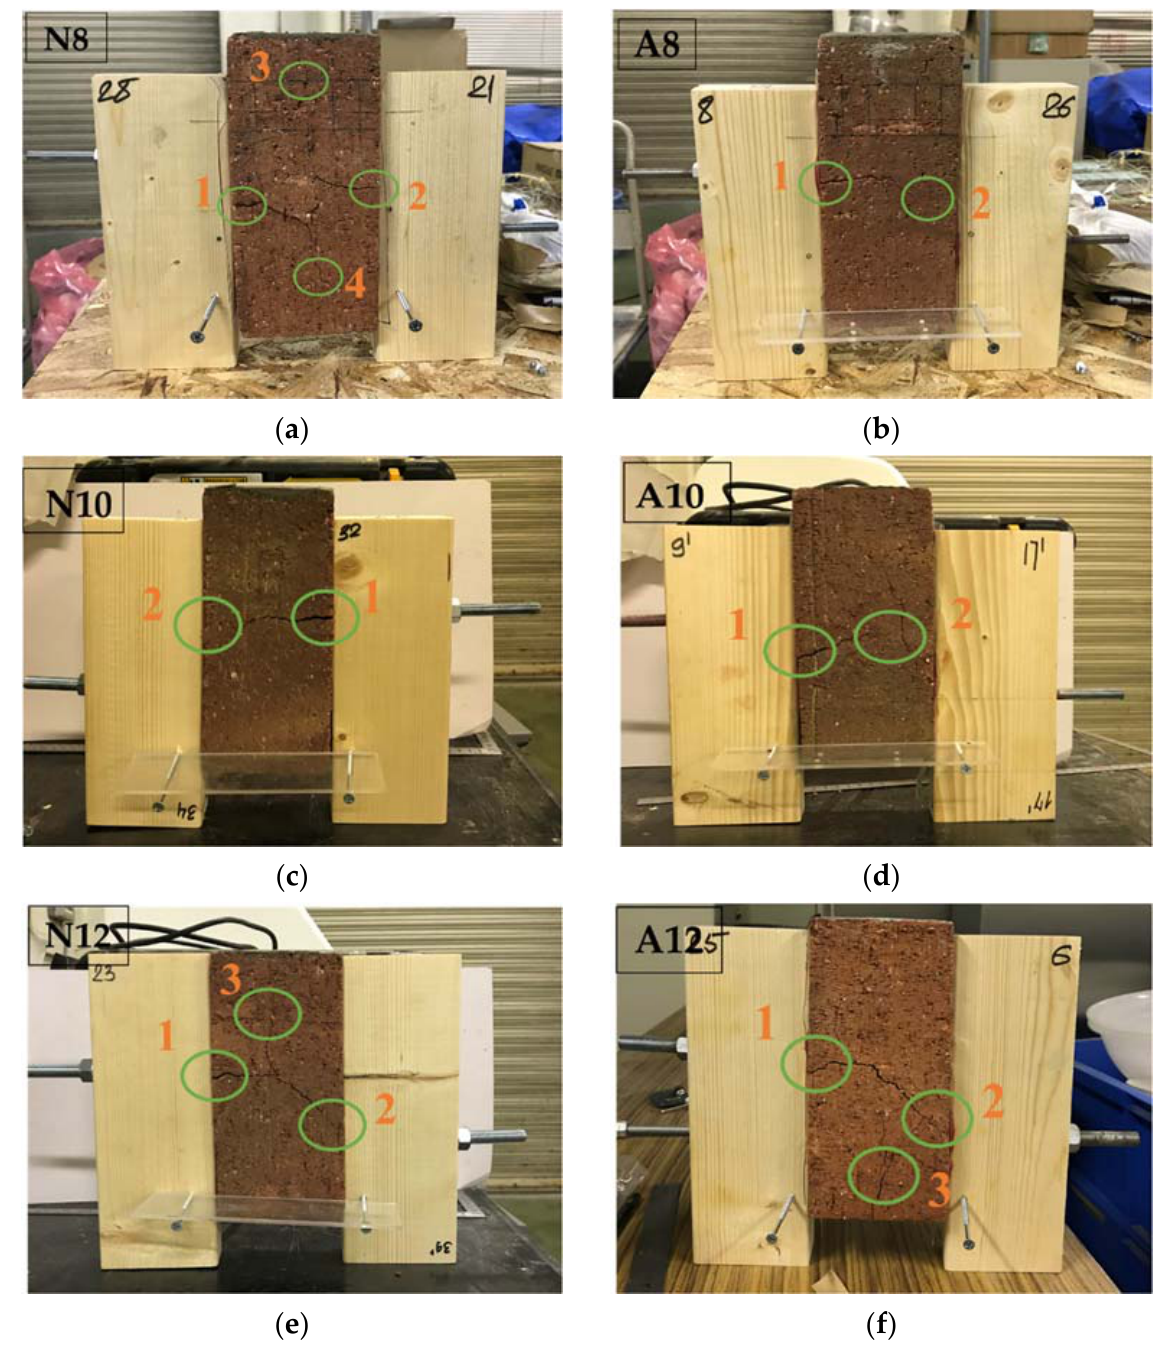
Figure 13. Crack on the brick (main member). ( a ) N8-1 specimen; ( b ) A8-1 specimen; ( c ) N10-2 specimen; ( d ) A10-2 specimen; ( e ) N12-3 specimen; ( f ) A12-2 specimen.